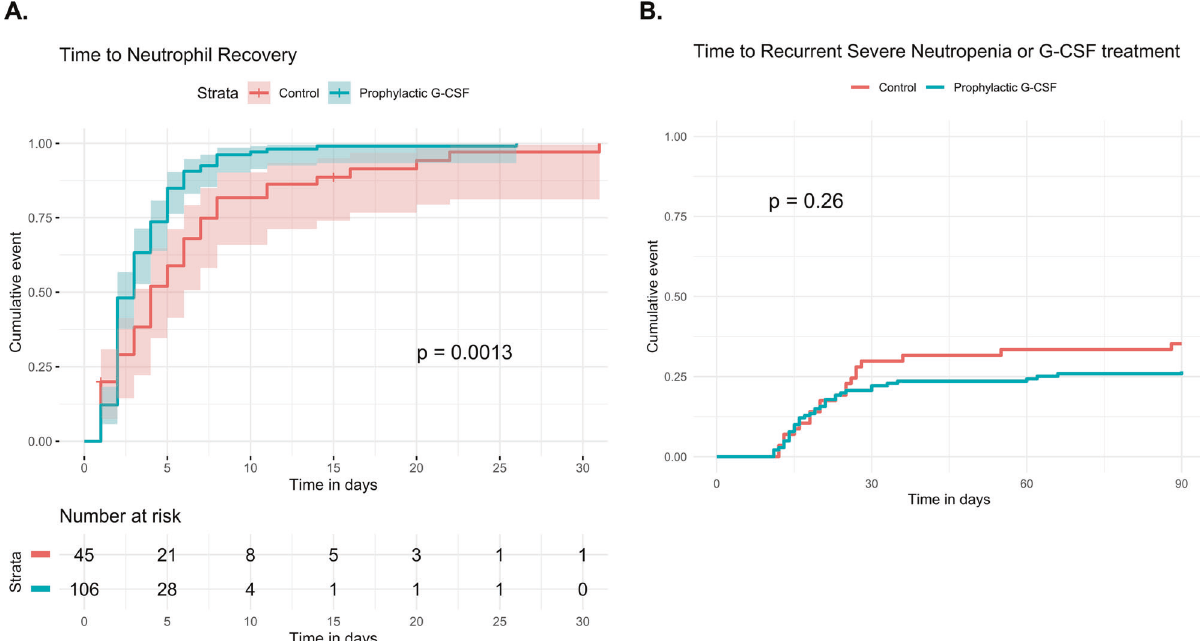
Fig. 1 Neutropenia in lymphoma patients treated with anti-CD19 CAR T cells. A Time to neutrophil recovery in the 151 lymphoma patients treated with anti-CD19 CAR T cells who developed severe neutropenia. Patients were strati fi ed by whether they received prophylactic G-CSF ( N = 106) or not (control, N = 45). Median time to neutrophil recovery was signi fi cantly shorter in the prophylactic G-CSF group (3 vs. 4 days, P < 0.01). In a multivariate Cox proportional hazards model, administration of prophylactic G-CSF prior to CAR T retained signi fi cance for